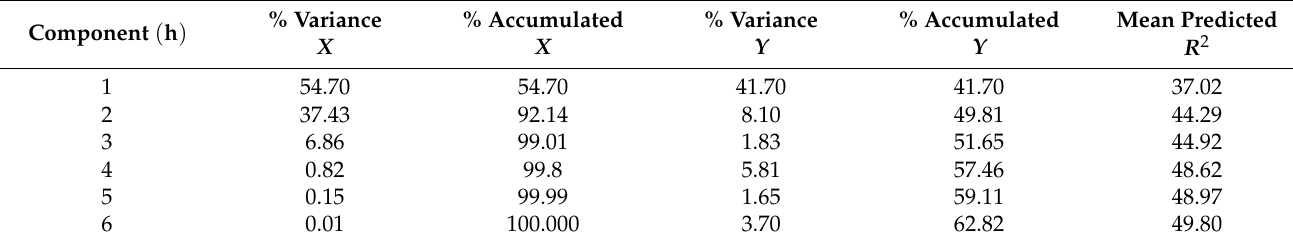
Table 7. Capability of explanatory ( X ) and response variables ( Y ) of PBT, PT, PR and PO associations to capture % of variance depending on the number of components. Predictive potential expressed as R 2 .